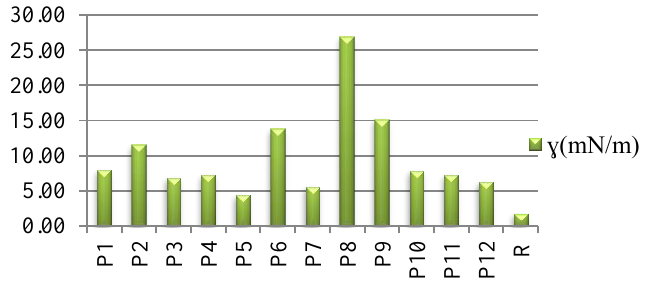
where 𝑐𝑜𝑠𝜃 = cosine of the measured contact angle; 𝛾 𝑙 = surface free energy for the liquid; 𝛾 𝑠𝐿𝑊 , 𝛾 𝑙𝐿𝑊 = dispersive component of surface free energy for solid ( s ) and liquid ( l ); 𝛾 𝑠+ , 𝛾 𝑙− = polar components of surface free energy (the donor and, respectively, the acceptor of electrons) for solid ( s ) and liquid ( l ).